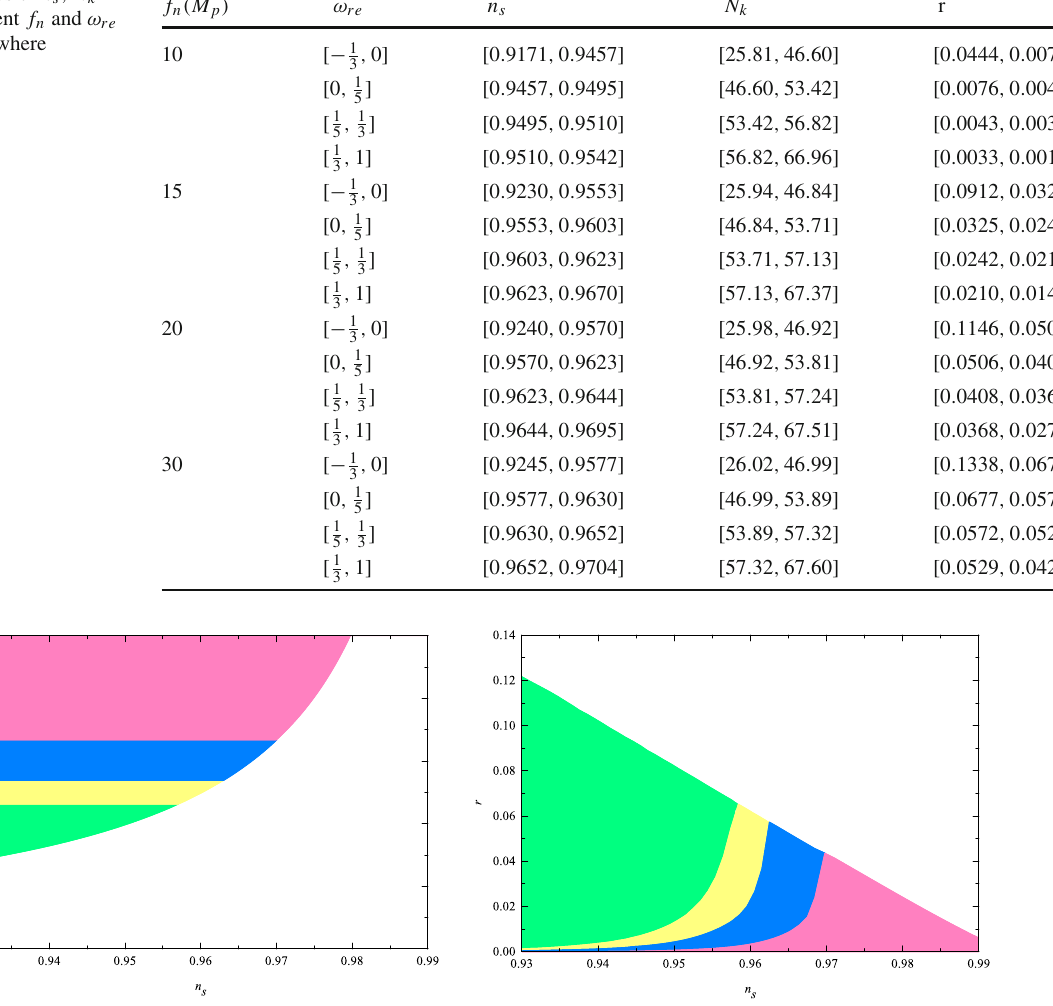
Table 3 The values of n s , N k and r under different f n and ω re of the NII model, where T